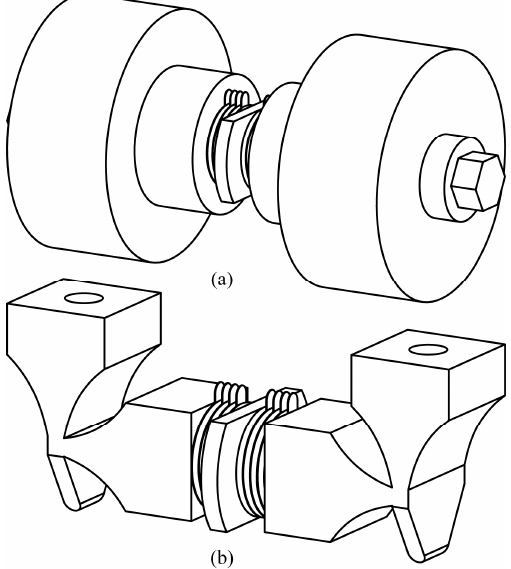
Figure 2. The assembly technique of the modified PUM: ( a ) The structure before secondary processing; and, ( b ) The structure after secondary processing. and, ( b ) The structure after secondary